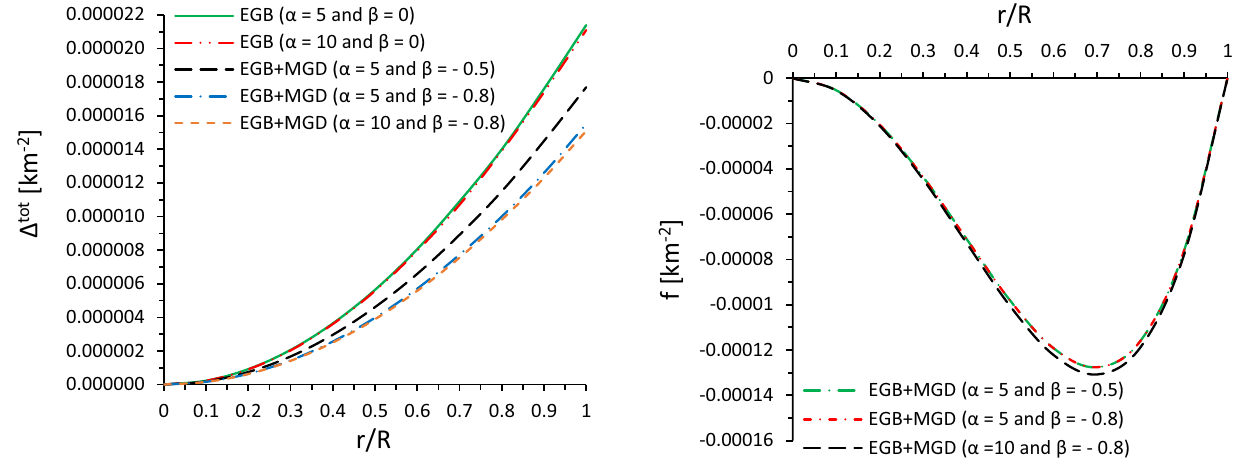
Fig. 3 The variation of total anisotropy [ (cid:22) tot = 8 π( P ⊥ − P ) ] and deformation function f ( r ) with respect to the radial coordinate r / R . Here, we use the same set of parameters as of Fig. 2